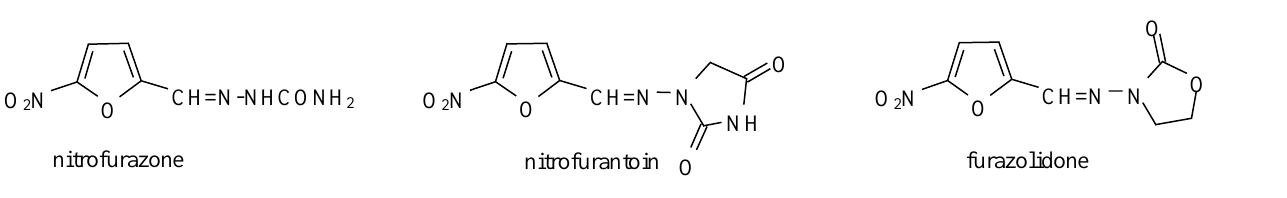
Figure 1: Antibacterial